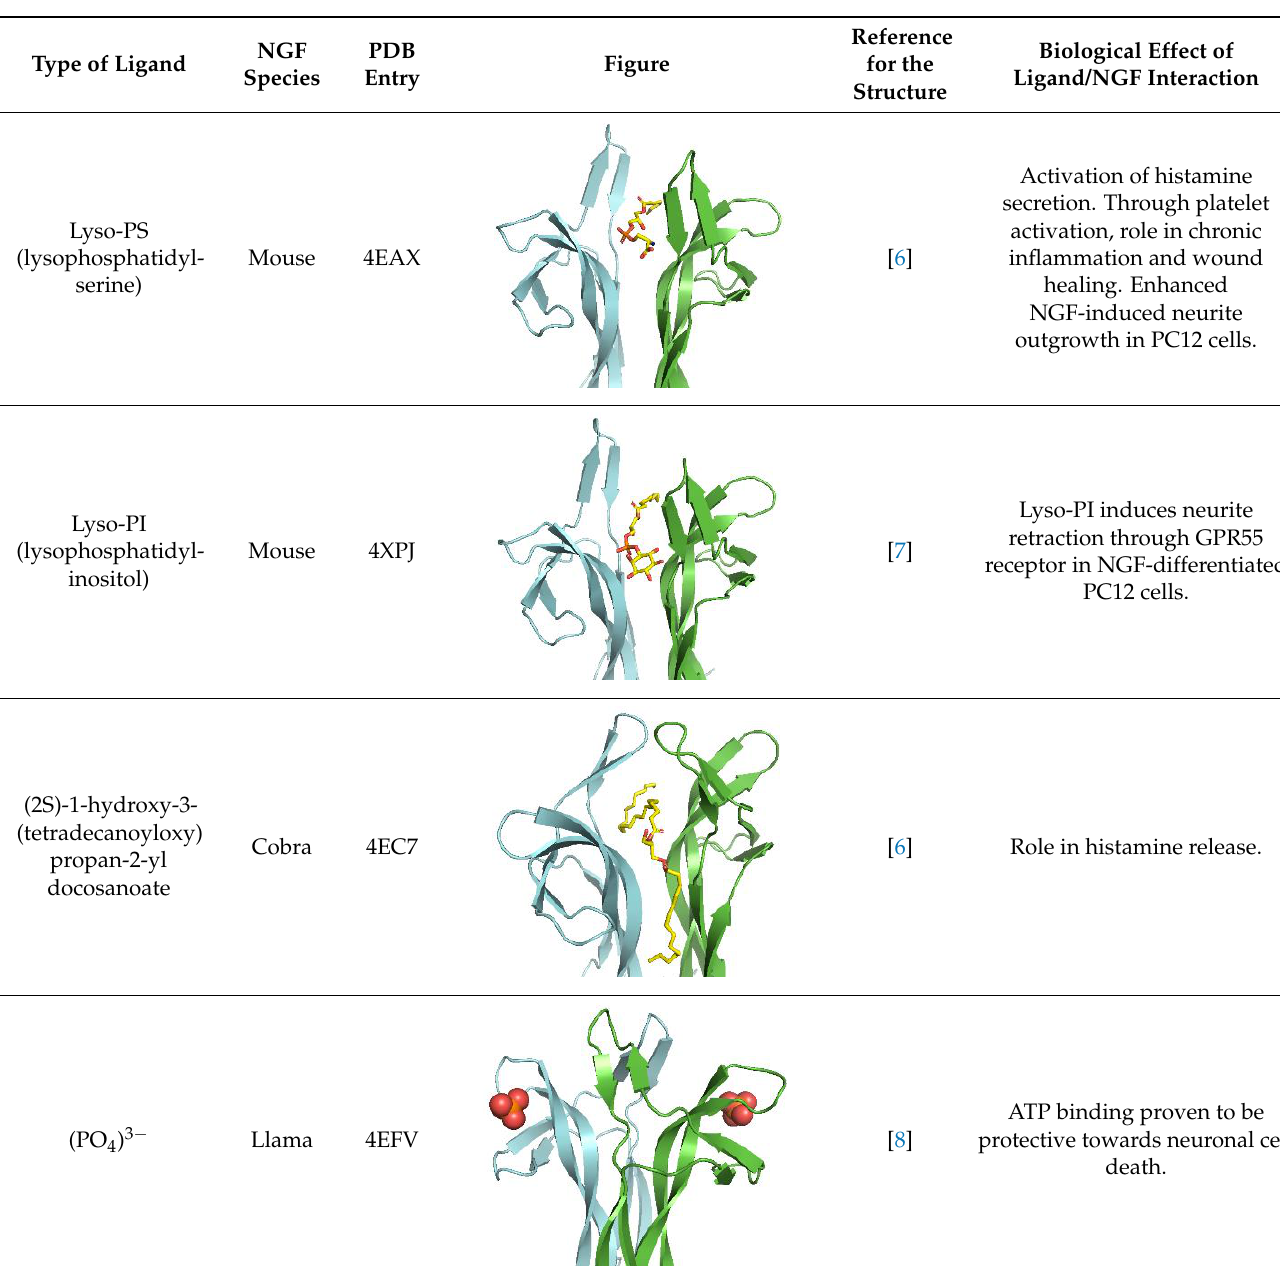
Table 1. Summary of the deposited PDB structures of NGF in complex with small endogenous ligands.